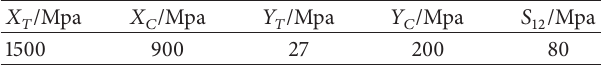
Table 1: Failure strengths of T300/914C.